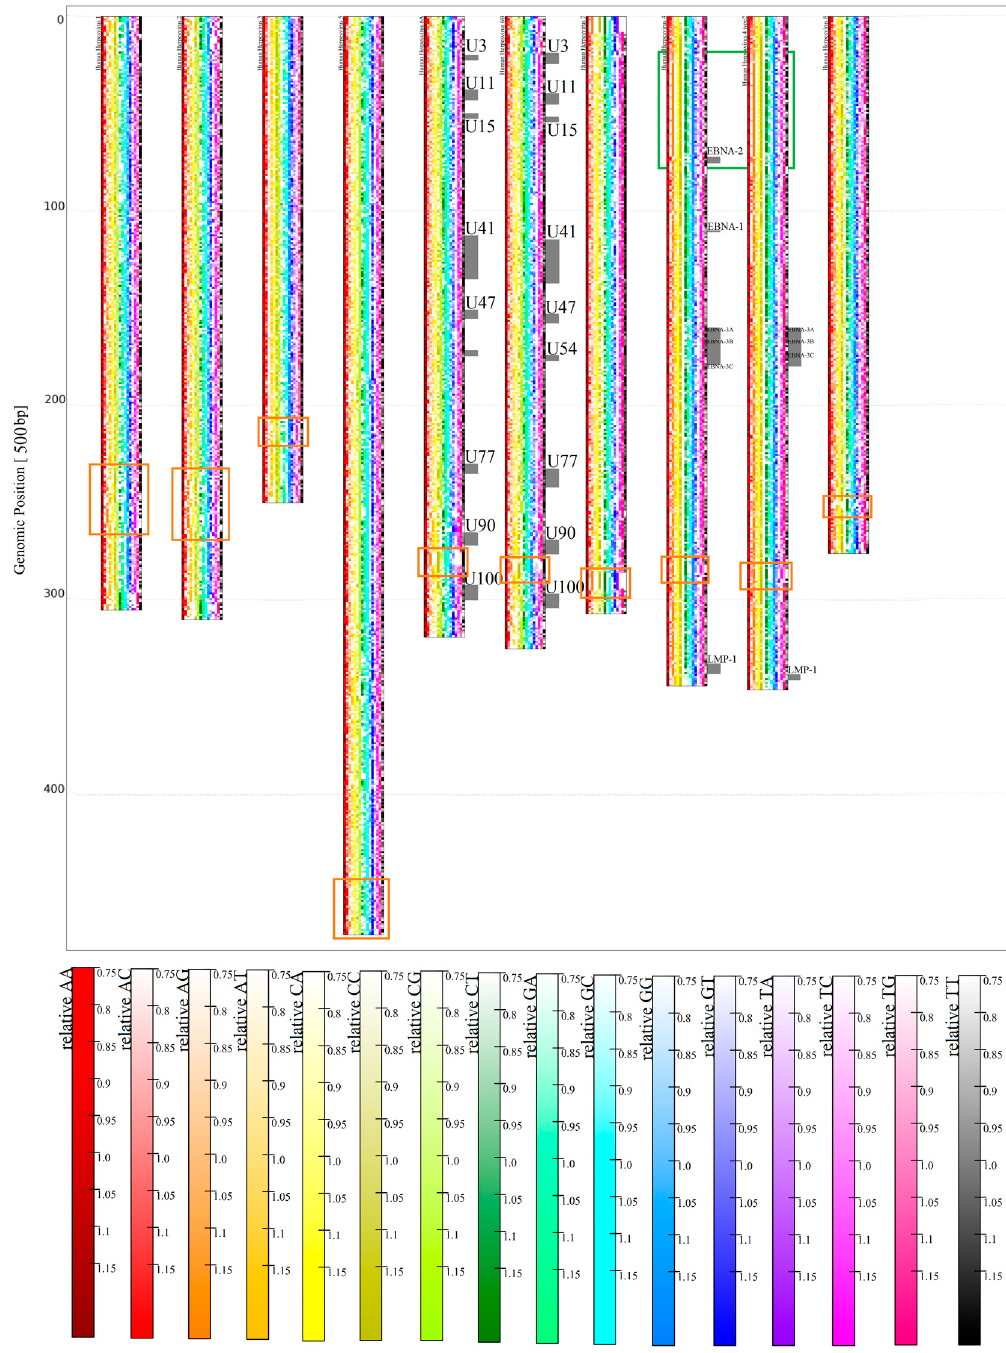
Figure 7. Map of HHV genomes for relative k = 2, with a bin width of 500 bp. From left to right: HHV1, 2, 3, 5, 6A, 6B, 7, 4 type 1, 4 type 2, 8. Peculiar patterns associated with high C or C/G content for k = 1 are marked orange, and the iterative structure at the top of 6A and 6B is marked green.